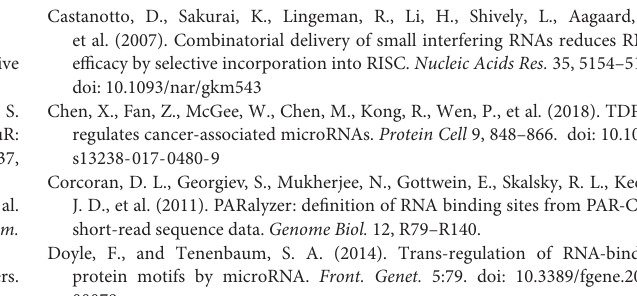
TABLE S6 | Complete list of overlapping RBP binding sites. This is a complete version of Table 3 . Each row represents an RBP-RBP pair, rows are sorted in descending order according to the number of overlapping binding sites. TABLE S7 | Binding sites of all the microRNAs sorted by microRNAs. (Please see website: http://sites.utoronto.ca/zhanglab/papers/RBP_miR/). Each row represents a microRNA; the chromosomal coordinates of the binding sites and the name of the gene targeted by the microRNA are listed as well. TABLE S8 | Binding sites of all the microRNAs sorted by target genes. (Please see website: http://sites.utoronto.ca/zhanglab/papers/RBP_miR/). Each row represents a target gene; the chromosomal coordinates of the binding sites and the name of the microRNA regulator are listed as well. TABLE S9 | List of microRNA-microRNA pairs that have the highest number of overlapping and neighboring binding sites. The first two columns are the names of the microRNAs, the 3rd column is the number of overlapping binding sites between these two microRNAs, the 4th column is the number of mRNAs on which these two microRNAs have overlapping binding sites. TABLE S10 | Complete list of overlapping microRNA-microRNA binding sites. This is a complete version of Supplementary Table S9 . Each row represents a microRNA-microRNA pair, the rows are sorted in descending order according to the number of overlapping binding sites. TABLE S11 | Complete list of overlapping RBP-microRNA binding sites. This is a complete version of Table 4 . Each row represents an RBP-microRNA pair, and these rows are sorted in descending order according to the number of overlapping binding sites. TABLE S12 | Top 100 RBP-microRNA pairs from regression analysis in 7 cancers. We use Fisher’s exact test to calculate the p -value of frequently occurring RBP-microRNA pairs in each cancer. Each row represents an RBP-microRNA pair. We sort the rows in ascending order according to p -value and select top 100 RBP-microRNA pairs for each cancer. Column 1 and 2 represent microRNA and RBP. Columns 3–9, respectively represent the p -value calculated by Fisher’s exact test in BRCA, KIRC, LIHC, LUAD, LUSC, PRAD, and THCA. TABLE S13 | Top 100 RBP-microRNA-mRNA trios form regression analysis in seven cancers. Top RBP-microRNA-mRNA trios. We used regression analysis to calculate the significant p -value to RBP-microRNA-mRNA trios and used Benjamini–Hochberg method to adjust the p -value to get the q -value. Each row represents an RBP-microRNA-mRNA trio. We sort the rows in ascending order according to q -value and select top 100 RBP-microRNA-mRNA trios for each cancer. Column 1, 2, and 3 represent microRNA, RBP, and mRNA. Column 4, 5, 6, 7, 8, 9, and 10, respectively represent p -value/ q -value calculated in BRCA, KIRC, LIHC, LUAD, LUSC, PRAD, and THCA. Column 11 represents the number of overlapping binding sites in RBP-microRNA-mRNA trios. Column 12 represents the ratio between overlapping binding sites and the sum of the number of microRNA target sites and RBP binding sites. TABLE S14 | Complete list of significant RBP-microRNA pairs in seven cancers. We used q -value less than 0.05 to screen the RBP-microRNA pairs for each cancer and count the number of their occurrences in multiple cancers. Column 1 and 2 represent microRNA and RBP. Column 3, 4, 5, 6, 7, 8, and 9, respectively represent the p -value calculated by Fisher’s exact test in BRCA, KIRC, LIHC,